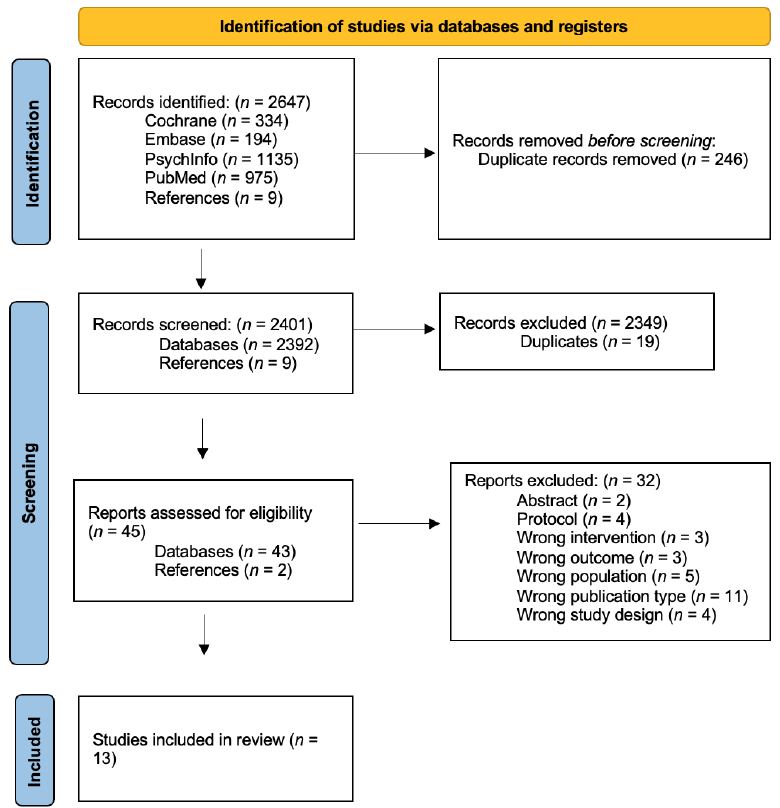
Figure 1. Preferred Reporting Items for Systematic Reviews and Meta-Analyses ( PRISMA) flowchart showing the steps of study inclusion [36] .